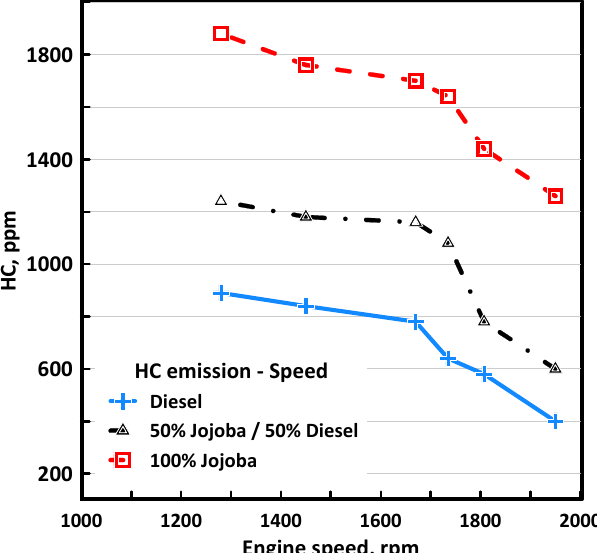
Figure 7. HC emission of pure diesel fuel, raw Jojoba oil, and 50/50